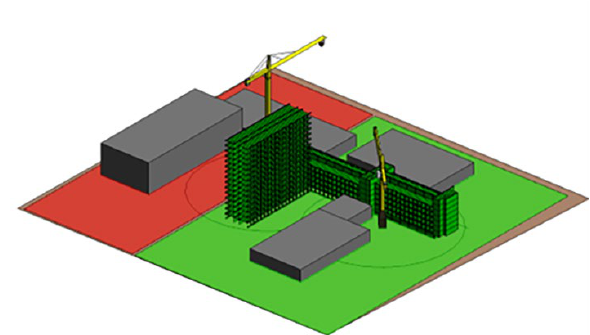
Figure 13. The plan for selecting the locations of the